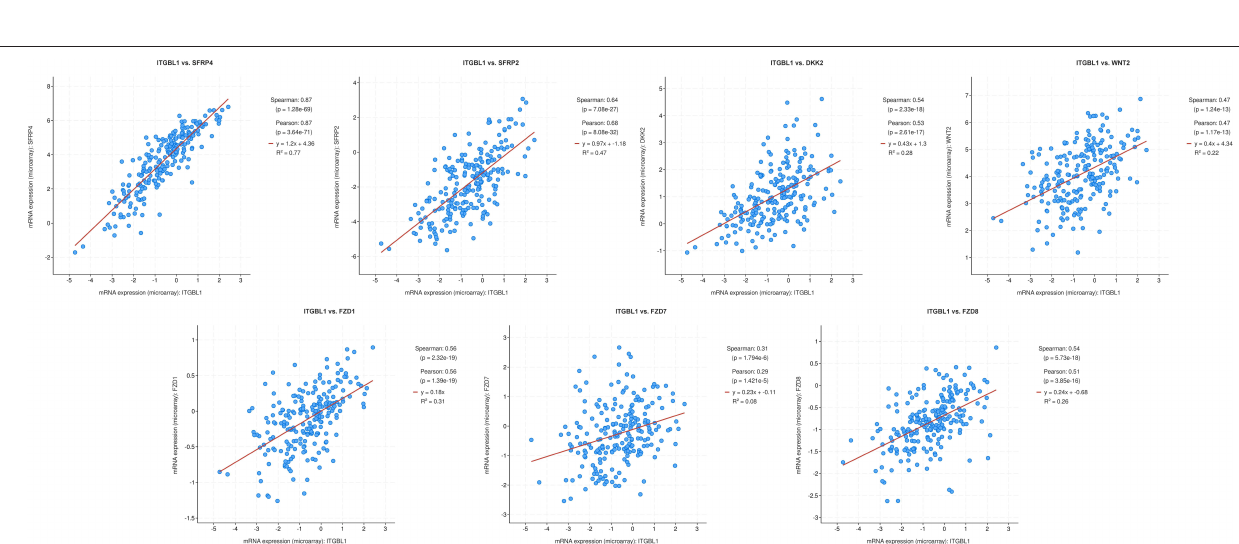
Frontiers in Oncology | www.frontiersin.org